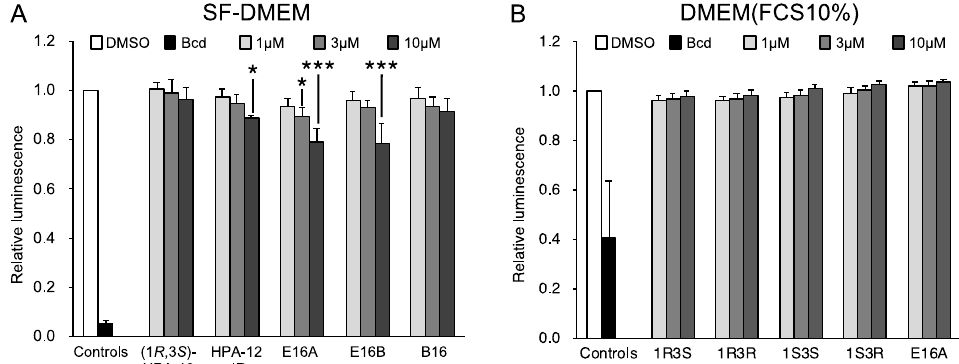
Figure 3. The level of ATP in HeLa cells is not affected by treatment with 3 µ M of HPA-12-IR. ( A ) HeLa cells were maintained in SF-DMEM with the indicated compound concentration for 2 days. ( B ) HeLa cells were maintained in DMEM/10% FCS with the indicated compound concentration for 30 h. The levels of ATP in the cells, assayed using the CellTiter-Glo v2 kit, are shown as the relative values compared to the vehicle DMSO-treated cells. The mean values ± SD from three experiments are shown. Dunnett’s test was performed to assess significant differences between compound treatments and the DMSO control. Statistically significant values (* p < 0.05; *** p < 0.001) are indicated. Bcd: 10 µ g/mL of blasticidin.